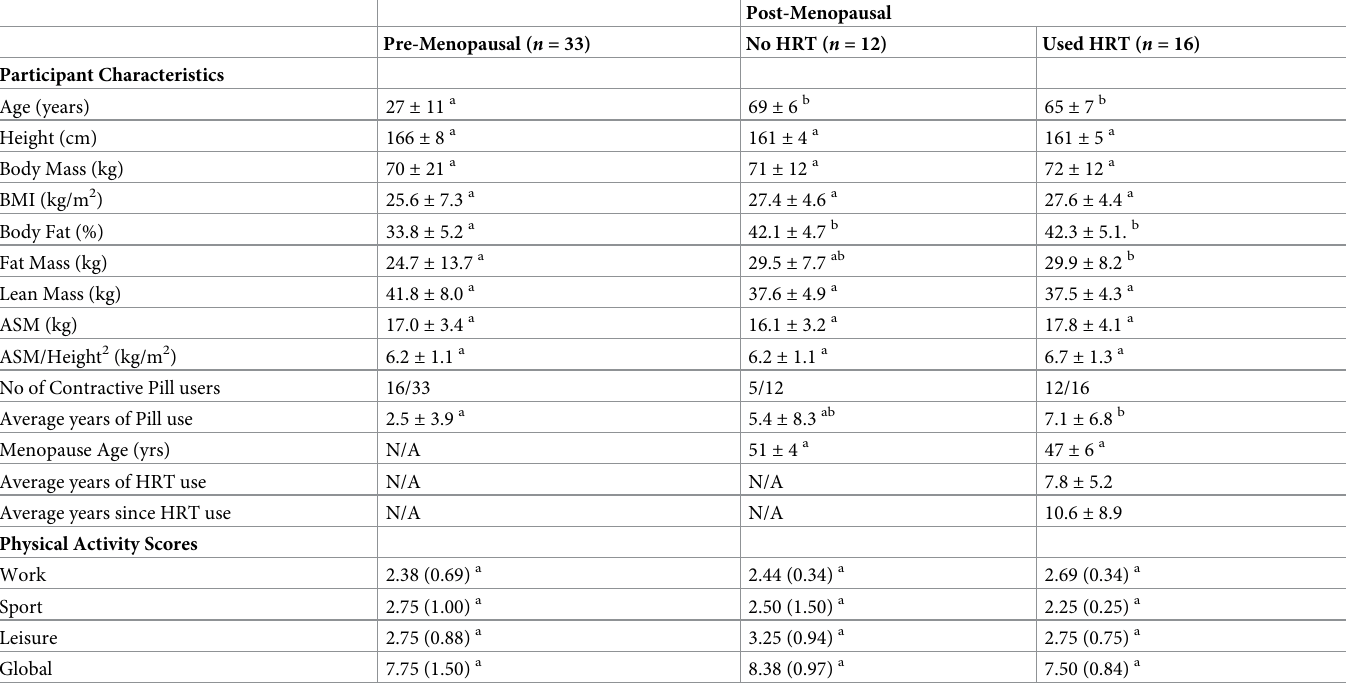
Table 1. Descriptive participant and hormone characteristics grouped by menopause phase and use of hormone replacement therapy (HRT).